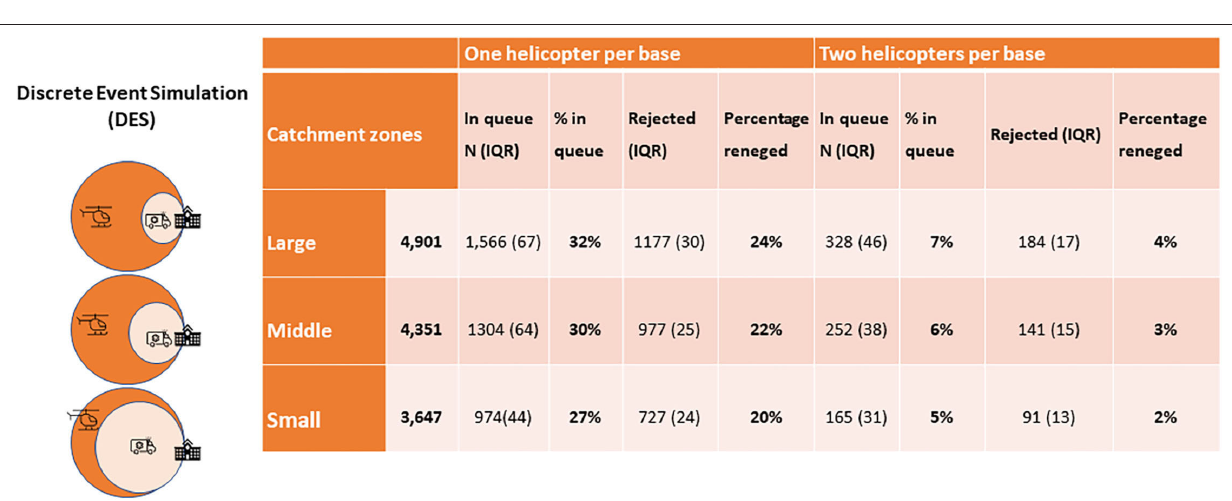
FIGURE 4 | Results of the discrete events simulation of 1000simulations. Showing the number of patients rejected and placed in a queue ( > 15min) awaiting transport to specialized hospital services (SHS). Large, 28 minutes to SHS with ground transport; Middle, 38 minutes to SHS with ground transport; Small, 48 minutes to SHS with ground transport. SHS, specialized hospital services; IQR, interquartile